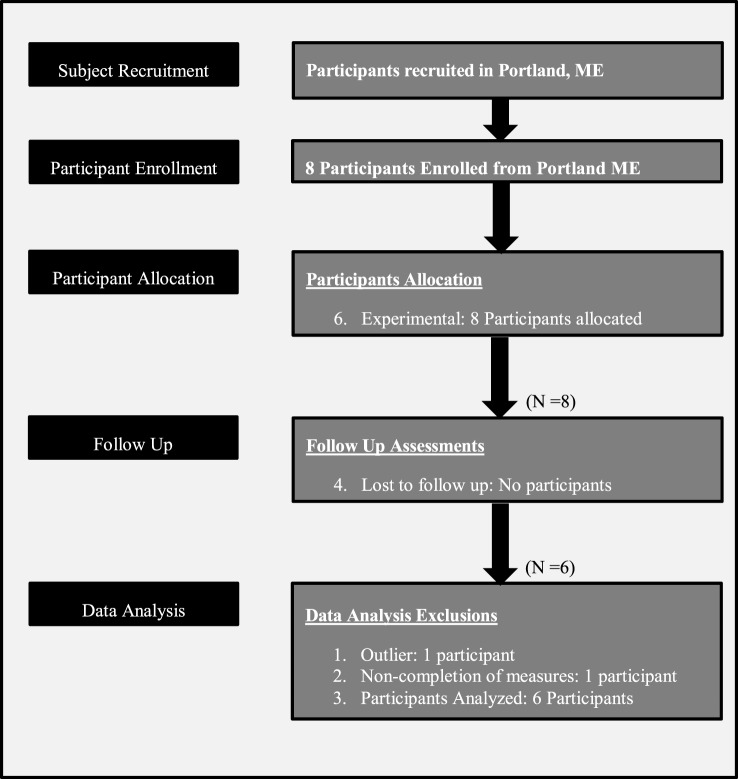
Participant flow.